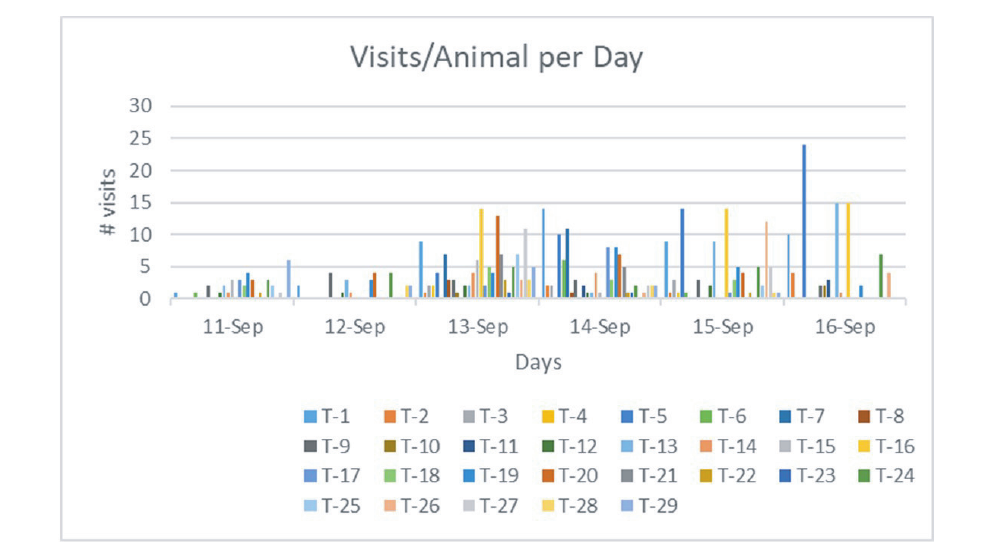
Figure 14. Recorded visits of the drinking stations by each individual